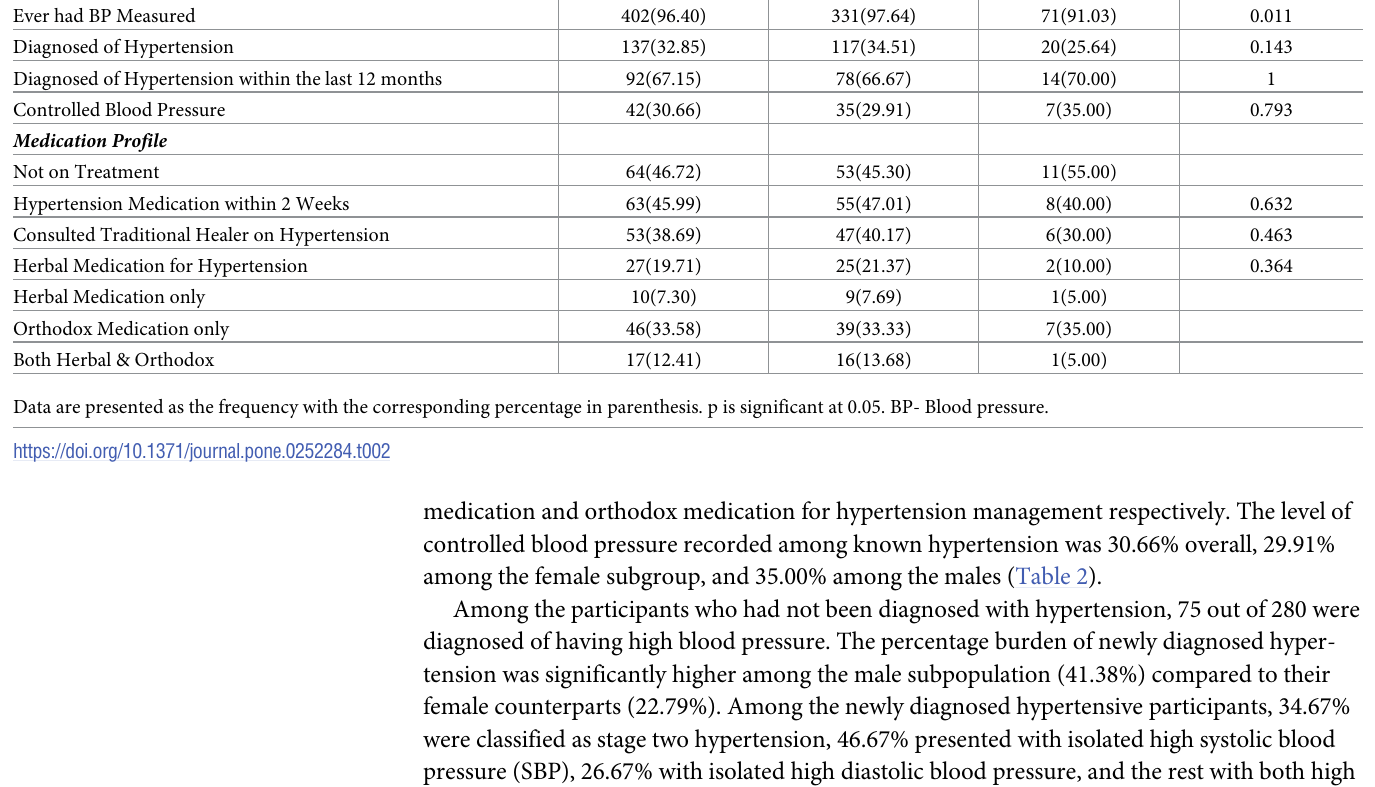
Table 2. Prevalence of known hypertension and treatment options among residents of Nyive